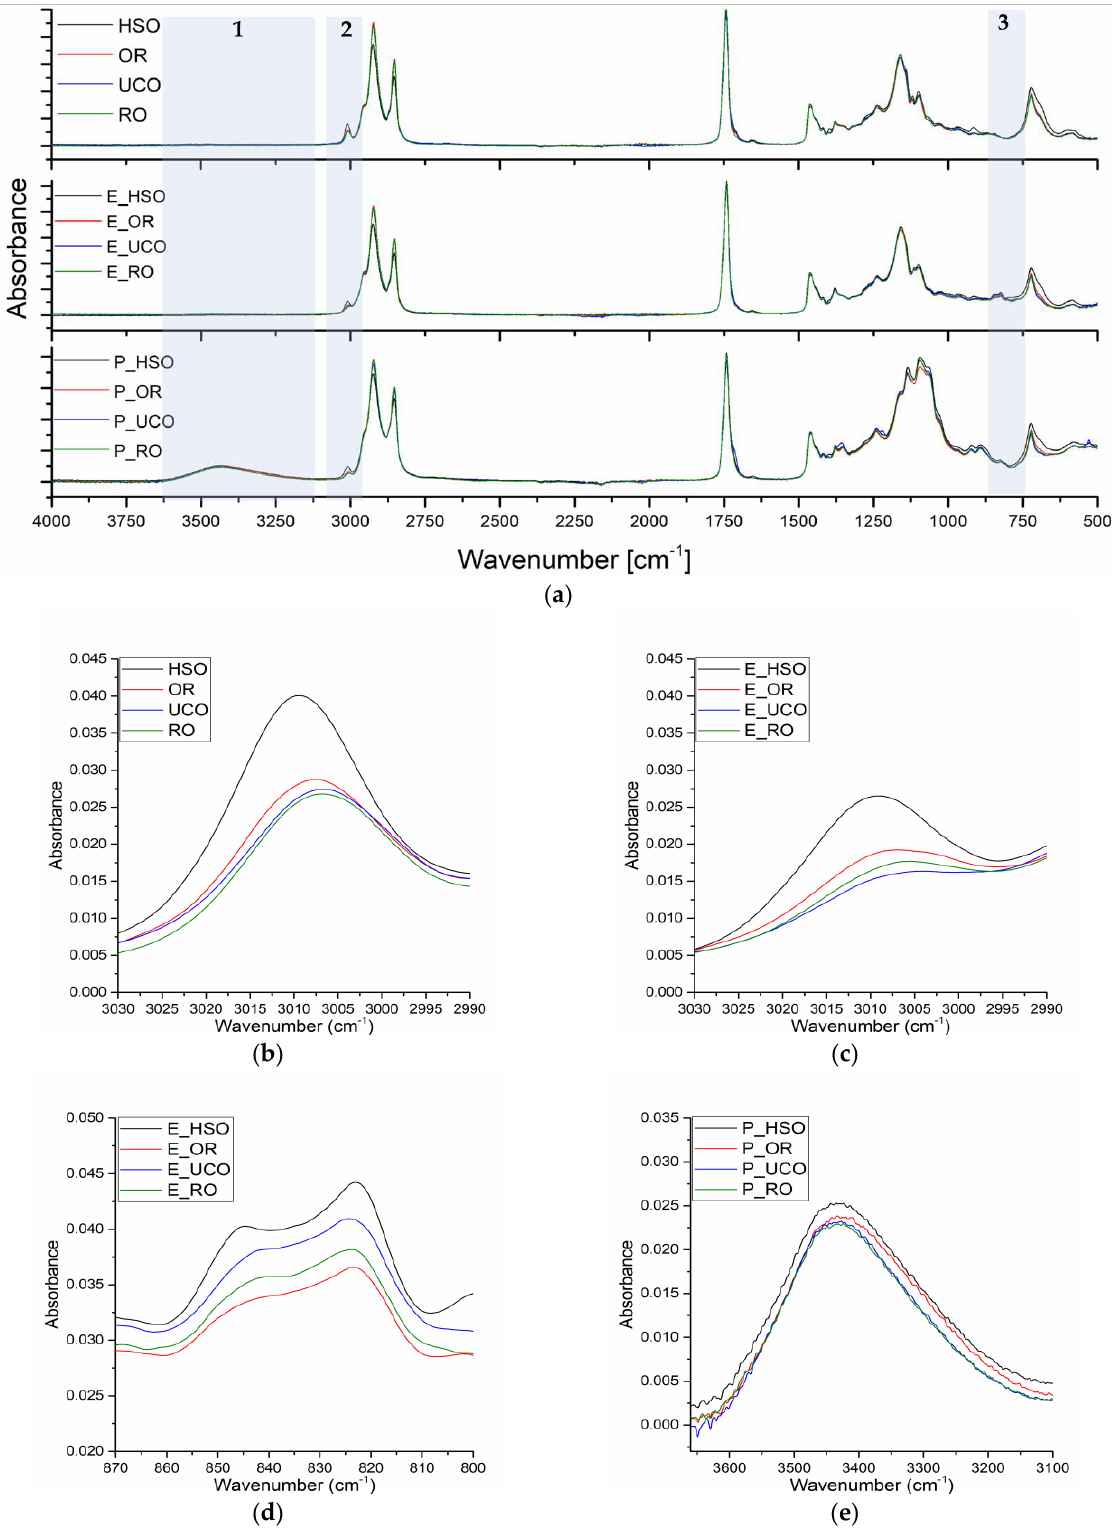
Figure 5. FTIR spectra: ( a ) overall spectra of oils, epoxidized oils and bio-polyols, ( b ) stretching vibrations of the cis-double bond (=C – H) of oils, ( c ) stretching vibrations of the cis-double bond (=C – H) of epoxidized oils, ( d ) oxirane ring vibrations, ( e ) hydroxyl group vibrations.